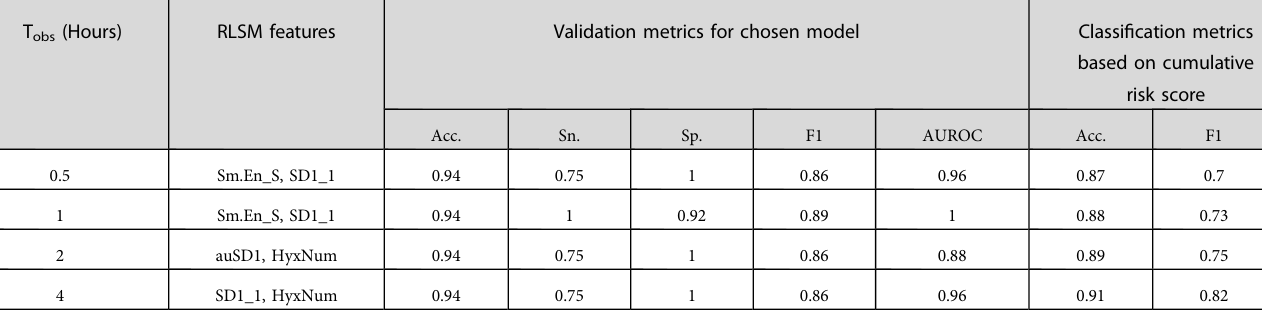
TABLE 3 Performance metrics of high-IH incidence detection with the cumulative risk score computed using chosen high performing RLSM models at each observation interval, T obs T obs (Hours) RLSM